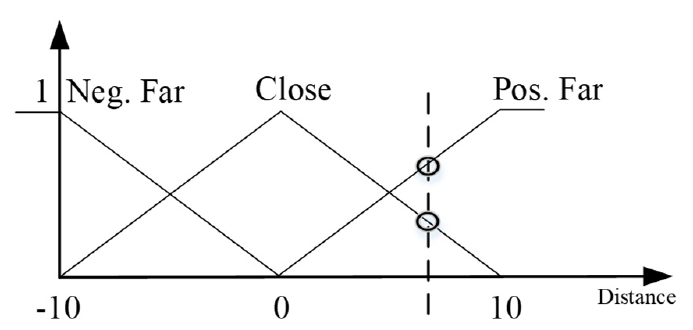
Figure 3. Triangular membership functions for the inputs.